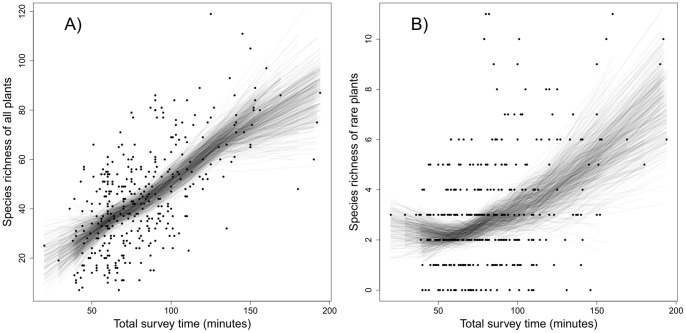
Effect of total survey time on (A) all plant richness and (B) rare plant richness using LOWESS (locally weighted scatter plot smoothing).